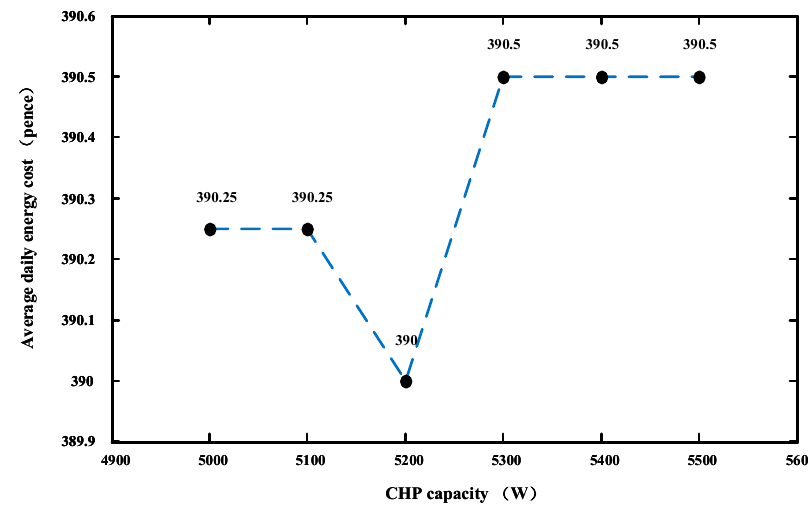
Figure 12. Average daily energy costs within theoretical best fuel cell CHP capacity region.